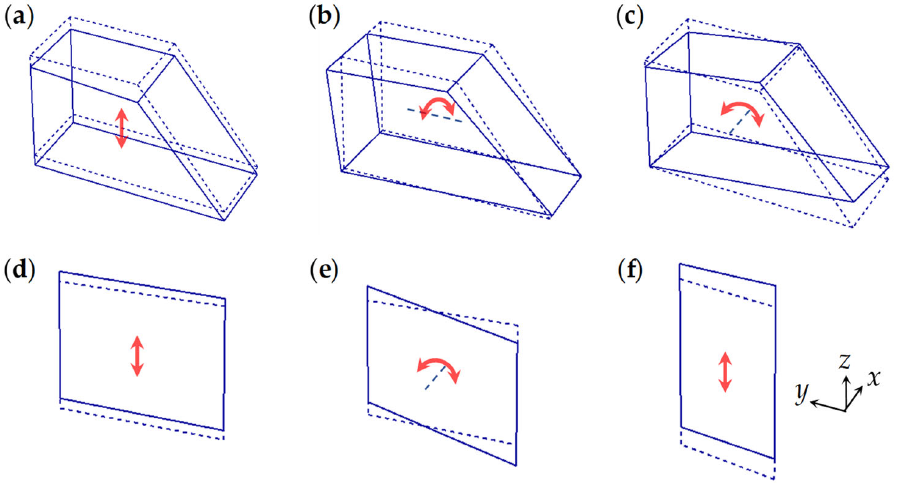
Figure 7. Mode shapes of the components: ( a ) bounce mode of the powertrain (4.8 Hz); ( b ) pitch mode of the powertrain (13.0 Hz); ( c ) roll mode of the powertrain (18.5 Hz); ( d ) bounce mode of the radiator (20.0 Hz); ( e ) roll mode of the radiator (30.3 Hz); and ( f ) bounce mode of the intercooler (29.3 Hz).